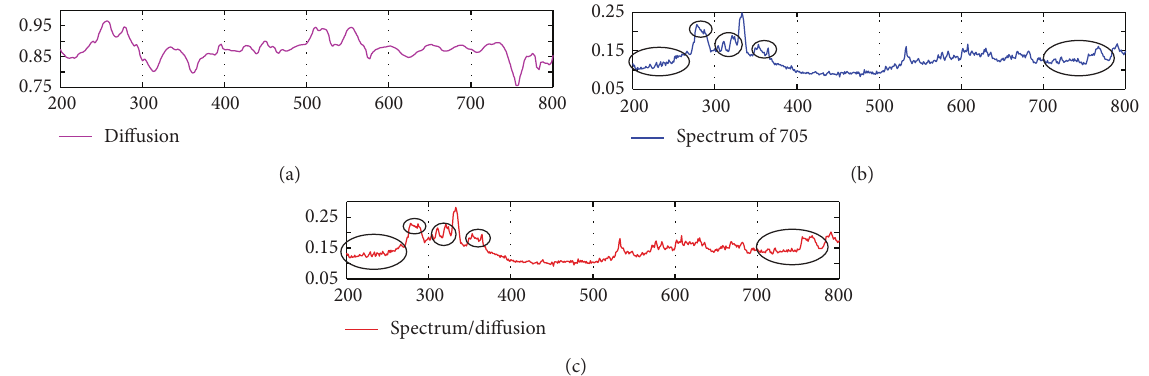
Figure 19: The 1D results of removing the influence of the topography applying our model (in all figures, 𝑥 -axis is wavelength (nm) and 𝑦 -axix is the reflectance). (a) simulated diffusion results; (b) 𝑦 -profile of CE-1 IIM data ( 𝜆 = 705 nm); (c) the result using the inverse model of our method to CE-1 IIM data. The featuring parts to show the changes after dividing the diffusion are